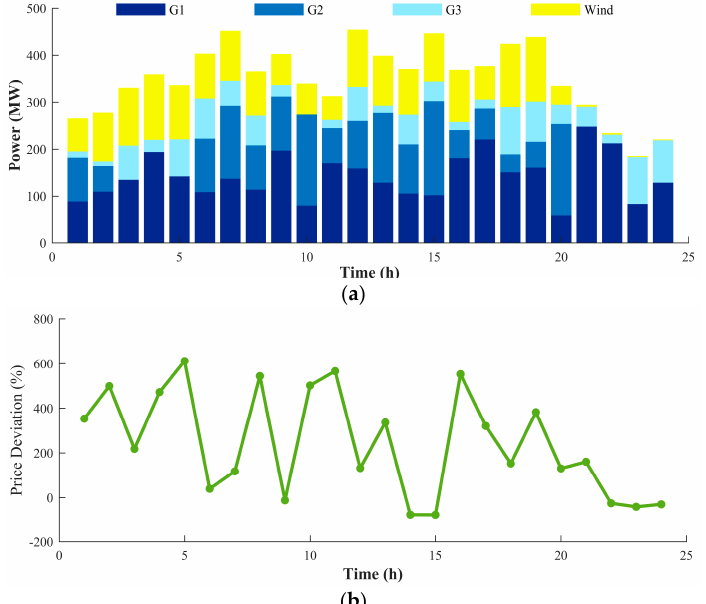
Figure 11. Dispatch result in Case 4. ( a ) Outputs of conventional generators and the wind turbine. ( b ) Price deviation for EV charging.